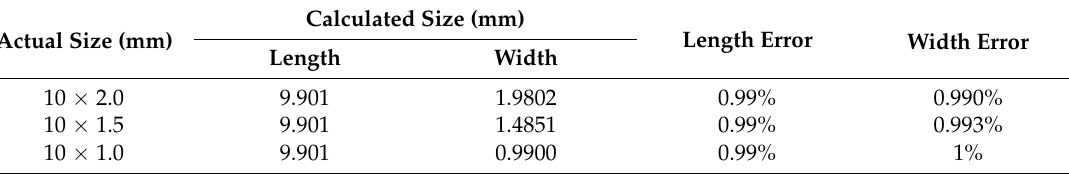
Table 2. Experimental results of three